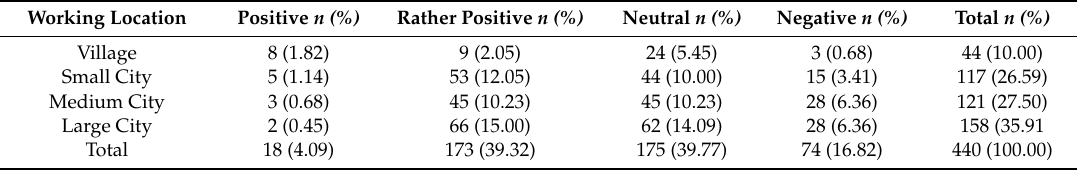
Table 2. Distribution (number of participants and percentage) of the association between future career prospects and working